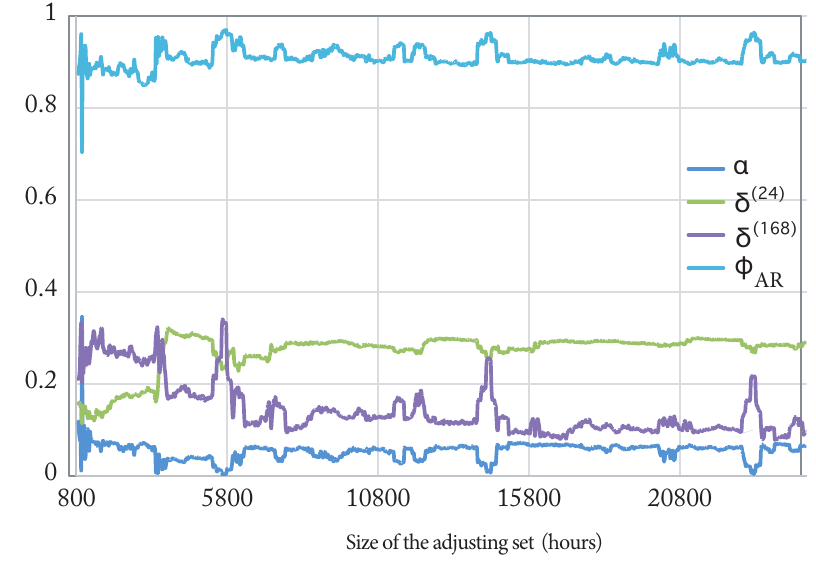
Figure 5. Evolution of parameters versus size of data